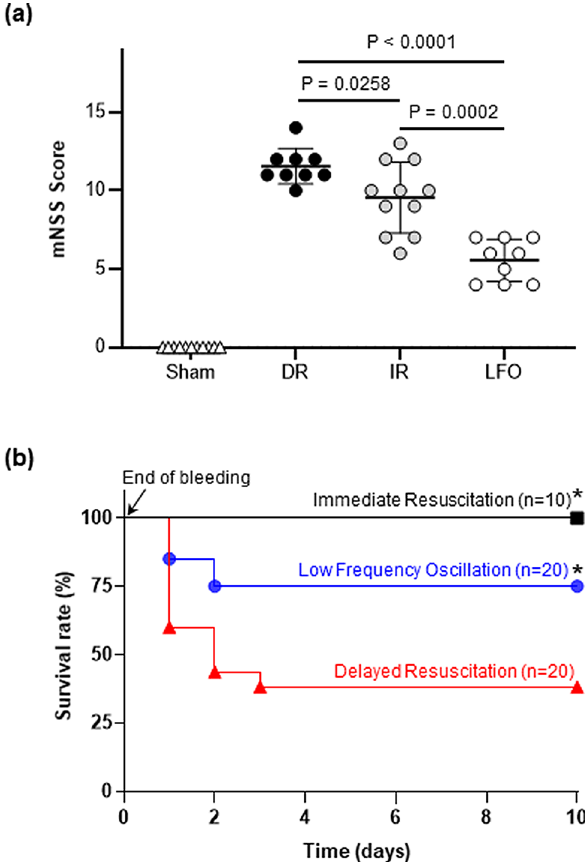
Figure 7. ( a ) TNS-induced low-frequency oscillations in CBF (0.1 Hz) improved neurological recovery at 24 h after TBI + HS. n = 10–16/group. ( b ) Kaplan–Meier survival curves. Induced low-frequency oscillations in CBF (0.1 Hz) improved the 10-day survival rate. * p < 0.05 versus delayed resuscitation group, n = 10 for immediate resuscitation group, n = 20 for delayed resuscitation group, n = 20 for induced low frequency CBF oscillation